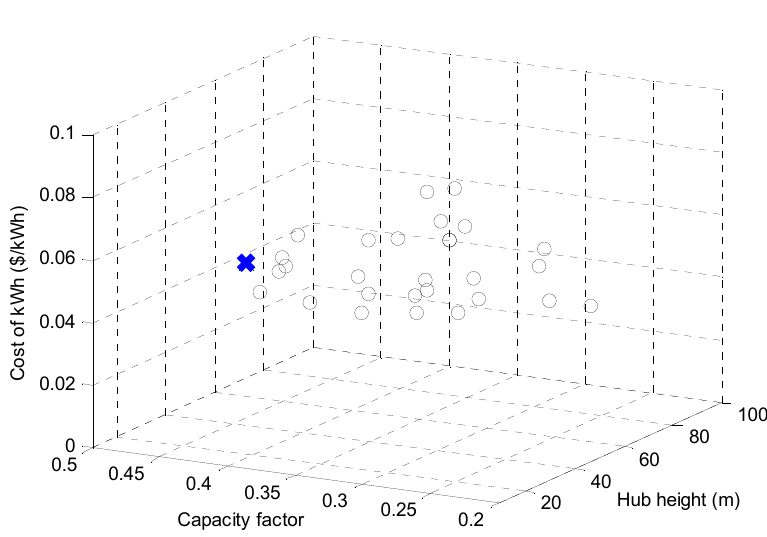
Figure 4. Initial (o) and final (x) conditions of PSO